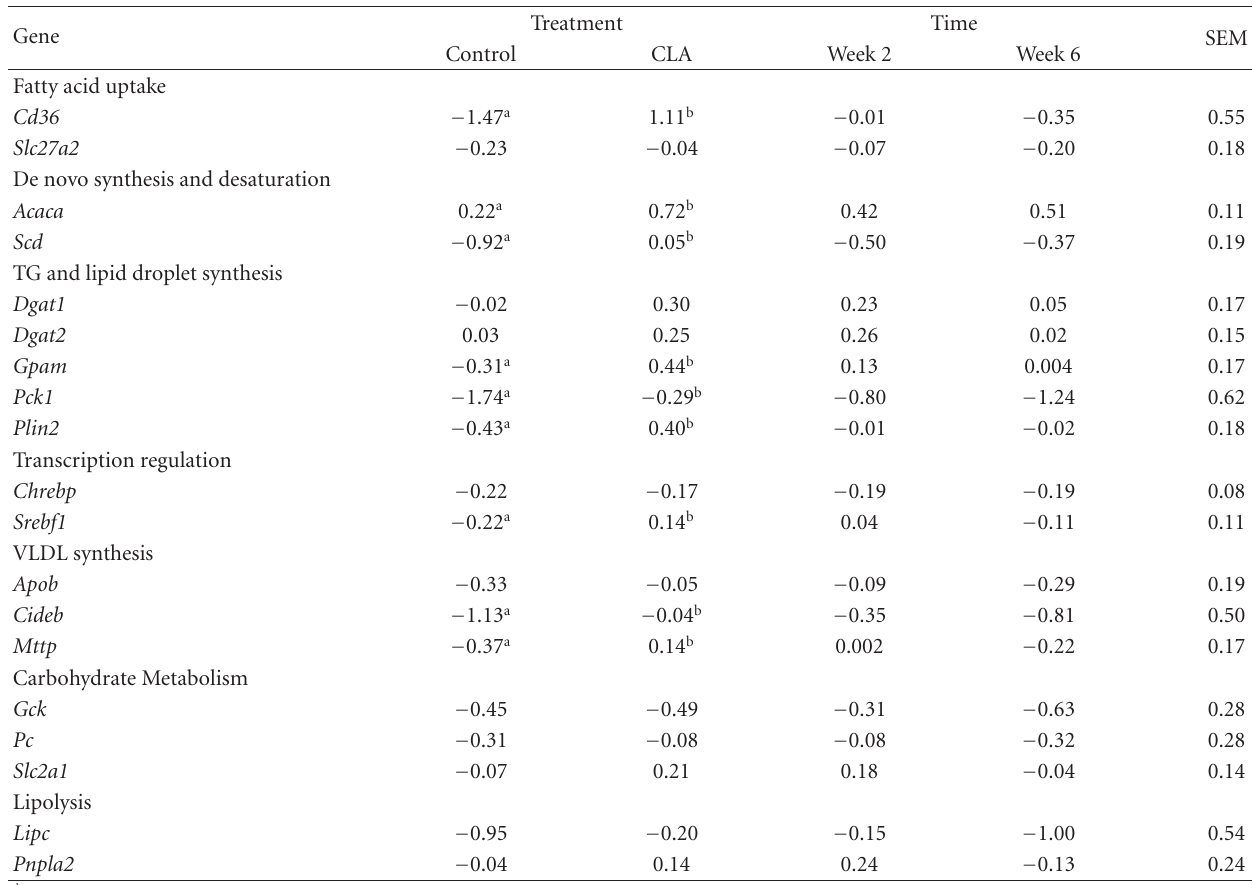
Table 4: Hepatic expression of genes related to LCFA uptake, lipogenesis, TG synthesis, lipoprotein synthesis, and transcription regulation in mice fed control or the control supplemented with trans -10, cis -12-CLA. There were no significant interactions of treatment × time. Therefore, the results are presented according to main e ff ects (treatment and